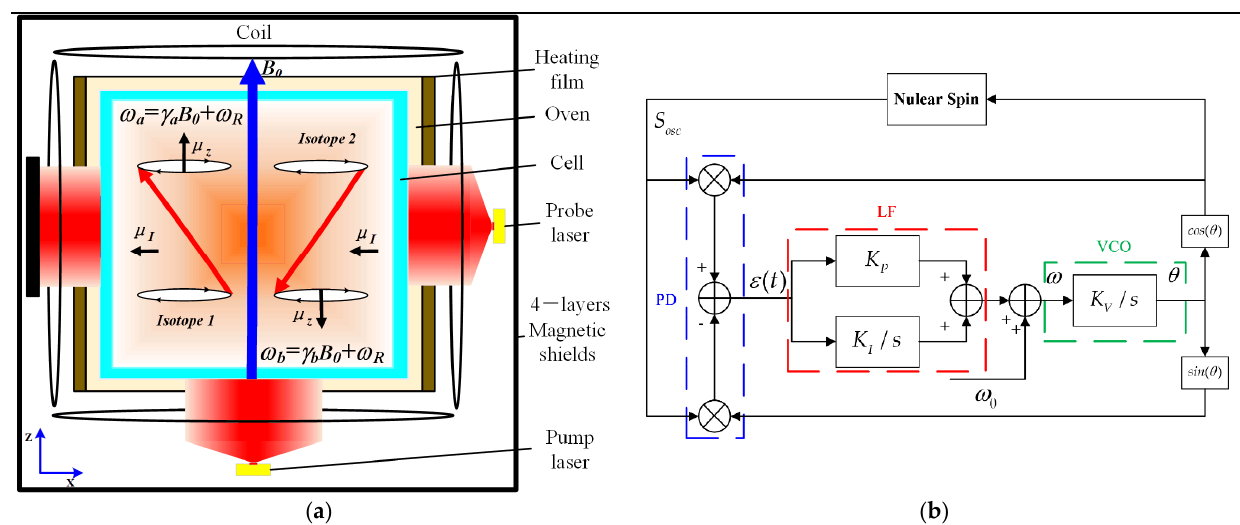
Figure 1. Typical schematic diagram of the NMRRS. ( a ) is the typical experimental arrangement of the NMRRS. ( b ) is the PLL - based single nuclear feedback control.